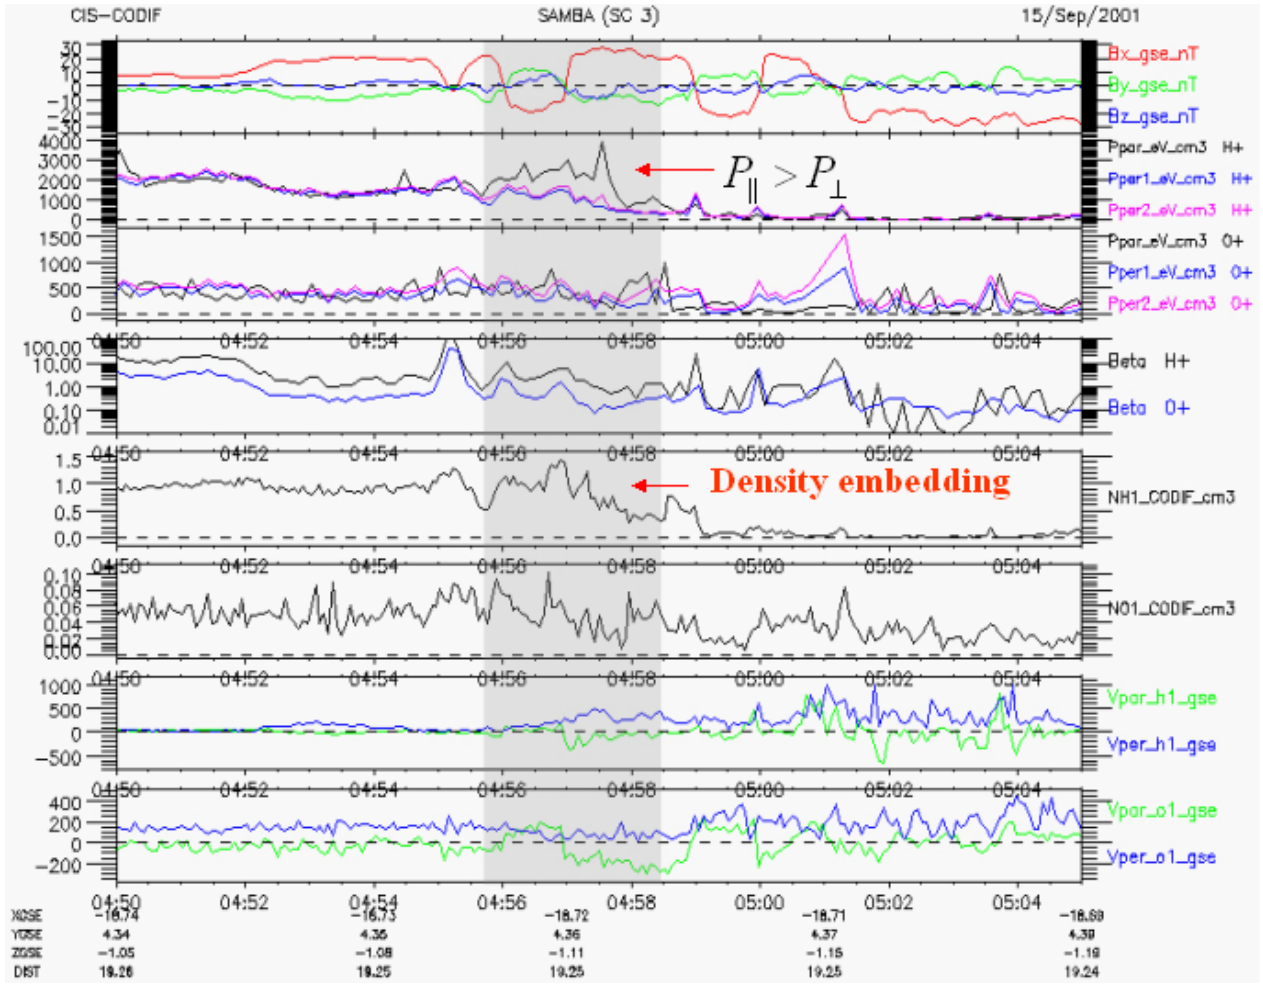
Fig. 4. 3-D momenta of proton and oxygen ions from C3. (a) the components of magnetic field. (b) and (c) are the pressure components. (d) is the beta value. (e) and (f) are the densities. (g) and (h) are bulk